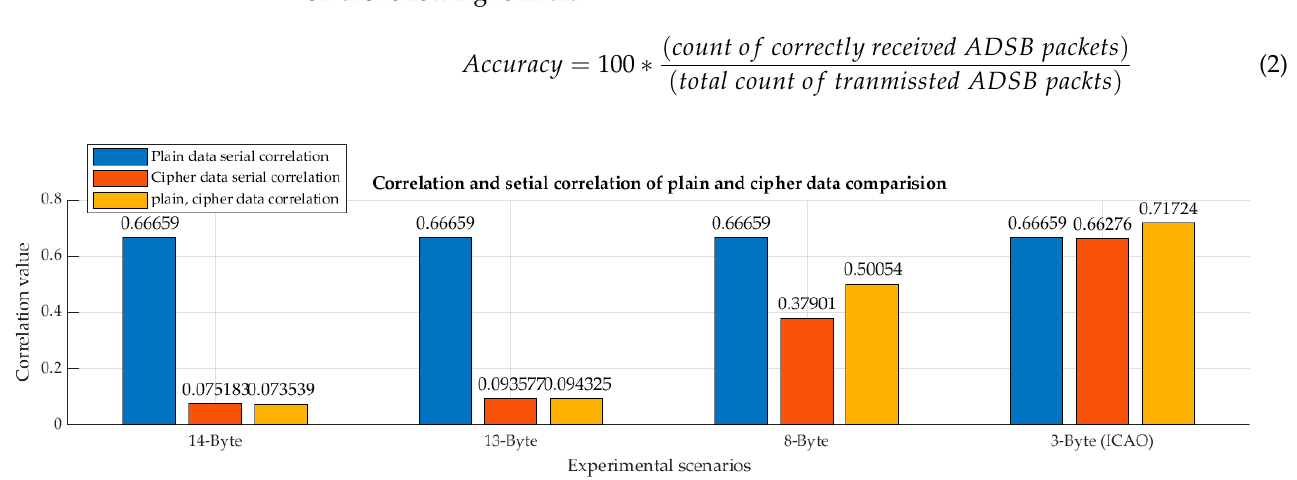
Figure 9. Correlation and serial correlation of plain and cipher data.